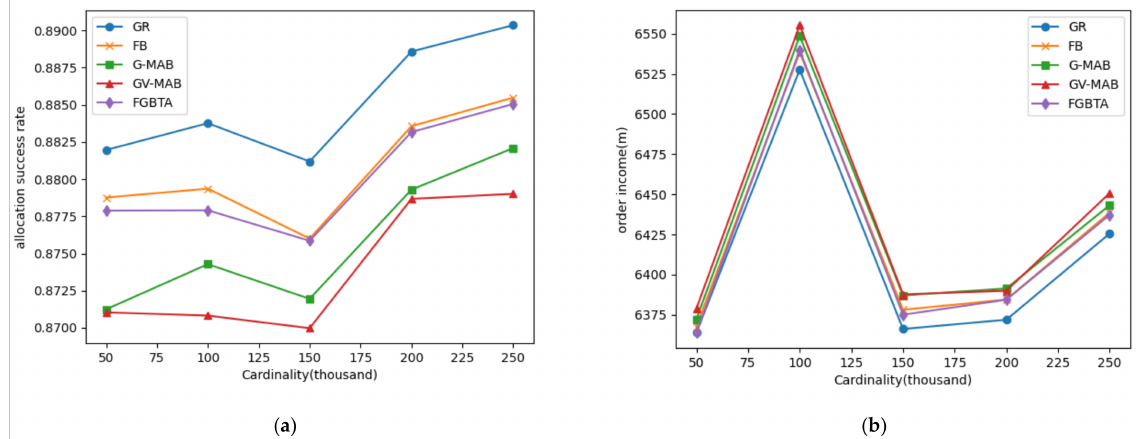
Figure 10. ( a ) Comparison of allocation success rate; ( b ) comparison of order income.